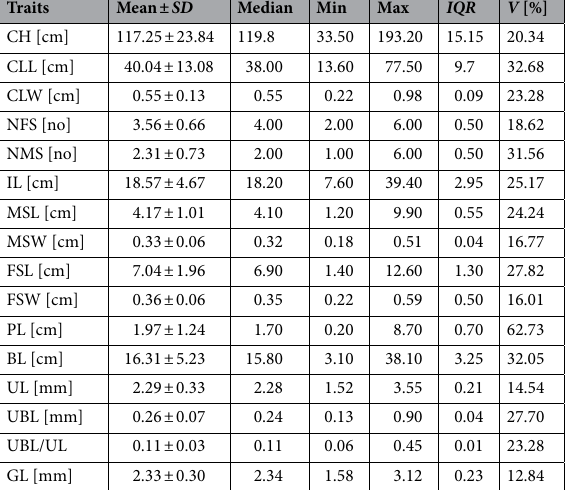
9 traits (Table S3). In most traits, the ranges of values were overlapping between the populations (Fig. 2). Generally, the most distinct and significant differences were observed in the culm height (CH) of populations 4 and 15; the leaf length (CLL) of populations 12 and 2; the leaf width (CLW) of populations 2, 3 and 20; the male spike length (MSL) of populations 3 and 10; the female spike length (FSL) of populations 1 and 9; the female spike width (FSW) of populations 1 and 16; the utricle length (UL) of populations 1, 2 and 8, 12, 23; the beak length (UBL) of popula- tions 1, 2, 4, 5 and 23; and the glume length (GL) of populations 1, 2, 7 and 15 (Fig. 2). The mean value of the beak length to utricle length ratio (UBL/UL) was at its lowest and highest in populations 5 and 23, respectively. Based on the cluster analysis involving 16 morphological traits, the C . buekii specimens were assigned to two different groups (Fig. 3). This division reflects the distribution of the samples (populations) in the phenetic space (Fig. 4). Populations representing group I (8, 10, 12, 15, 17, 18, 19, 20, 21, 22, 23, 24, 25, 26) occupy the space on the left-hand side of the first (horizontal) axis, whereas populations making up group II (1, 2, 3, 4, 5, 6, 7, 9, 11, 13, 14, 16) are placed in the right-hand side of the plot (Fig. 4). Along the first axis, populations 2, 3 and 4 (right-hand side) as well as population 12 (left-hand side) are farthest away from the plot centre. The strongest effect on the first PCA axis was exerted by the culm height (CH), the cauline leaf length and width (CLL and CLW), the inflorescence length (IL), the male spike length (MSL), the bract length (BL), and the glume length (GL). The second axis was determined mostly by the female spike width (FSW), the utricle length (UL), the utricle beak length (UBL), and the glume length (GL) (Fig. 4A). The traits associated with the third axis included primarily those related to the female spike length (FSL), the peduncle length (PL), and the beak length to utricle length ratio (UBL/UL) (Fig. 4B). The first three principal component axes, taken together, explained 61% of the variance (31%, 18% and 12%, respectively). The fourth principal component axis explained 10% of the variance, other axes explaining a still lower percentage (Table S4). The Mann–Whitney U test showed the two C . buekii groups described above to differ significantly in 13 morphological traits (Table S5). The group I specimens are generally smaller, show shorter and narrower leaves, have fewer female spikes, their inflorescences are shorter, their male spikes are shorter and wider, their female spikes are narrower, their bracts are shorter, their utricles are smaller, and the utricle beaks are shorter than those in group II. In addition, the beak length to utricle length ratio in group I is lower than that in group II (Fig. S1).